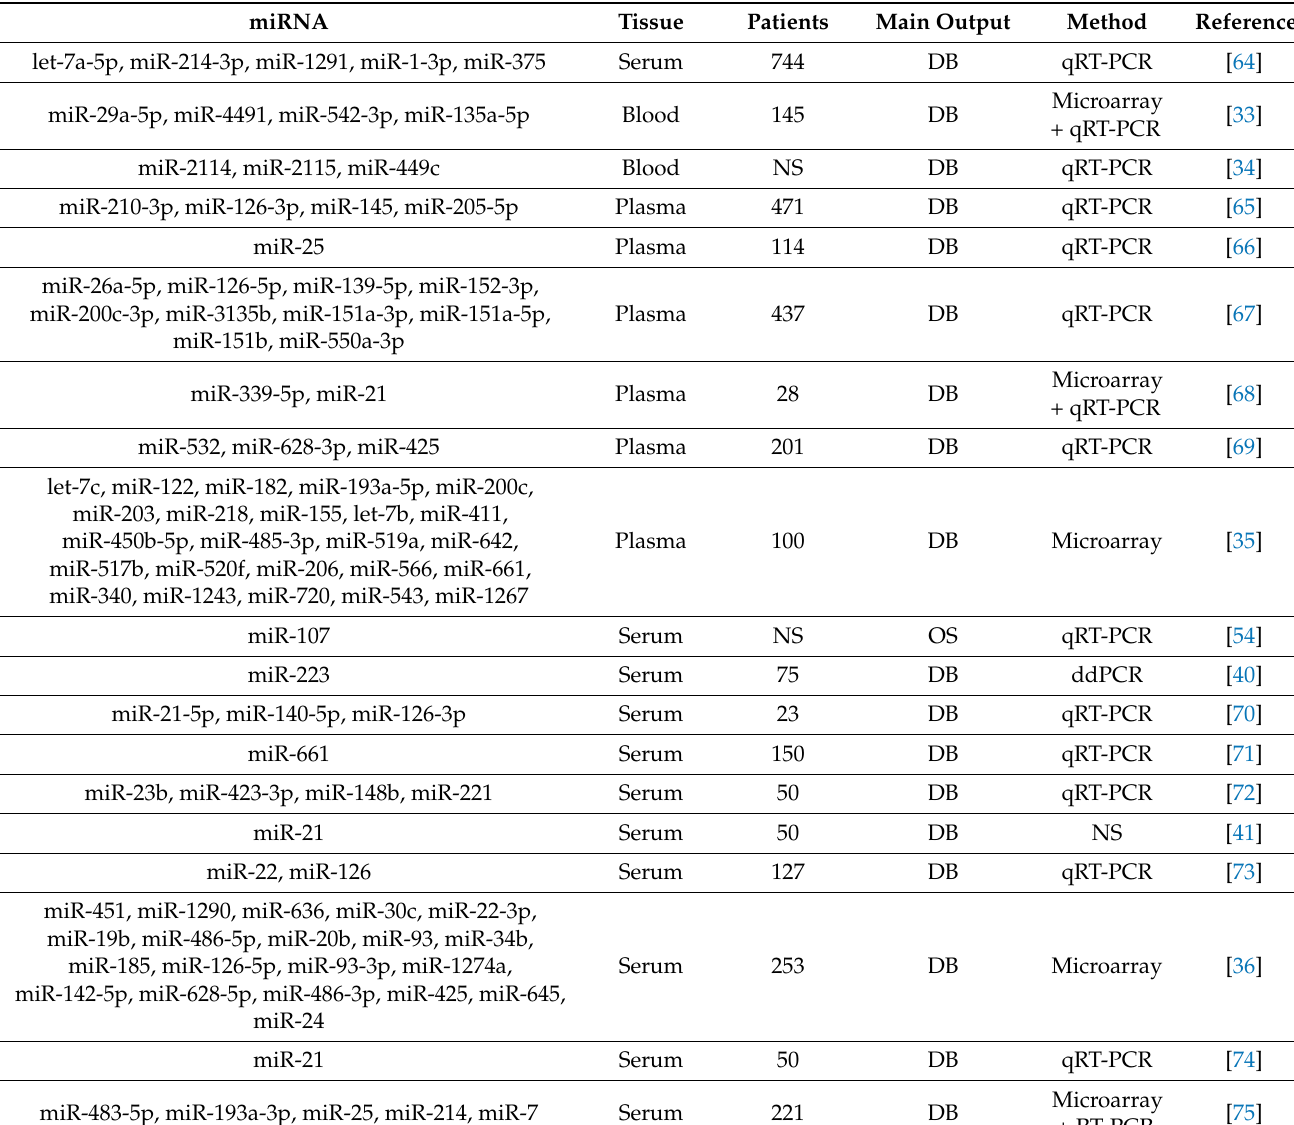
Table 1. An overview of studies focused on relationships between lung cancer and miRNA expression. miRNA